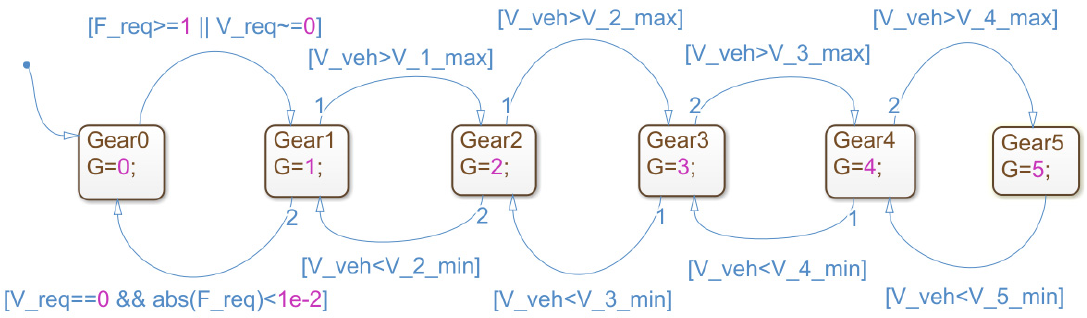
Figure 12. The gear definition control.